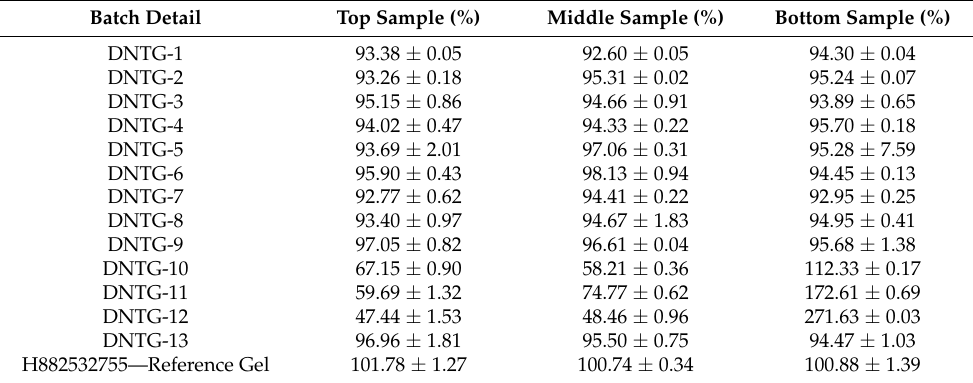
Table 5. Desoximetasone niosomal gel content uniformity data ( n = 3, mean ± SD). Batch Detail Top Sample